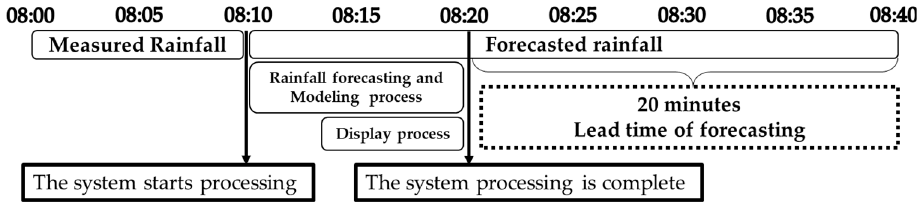
Figure 11. Forecasting performance in CSI (%) in the rainfall forecasting process.